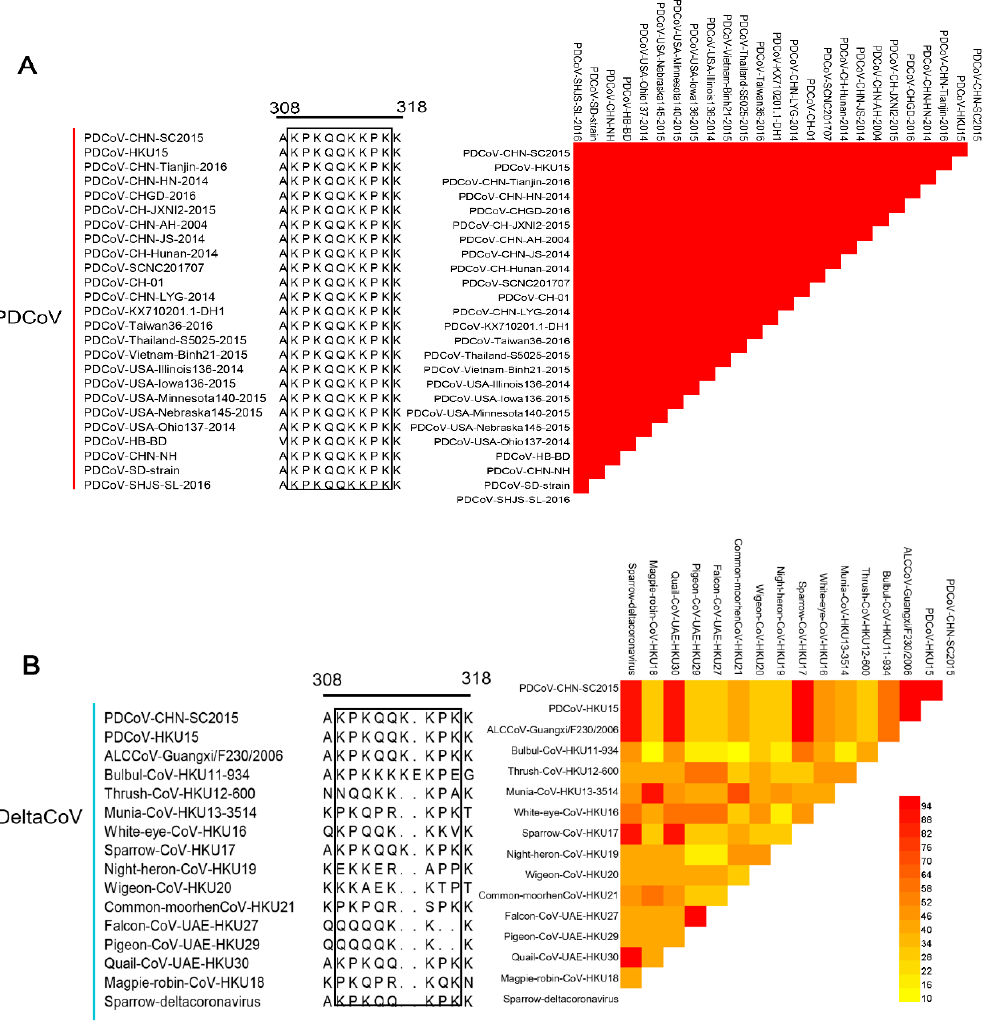
Figure 5. Reactivity of mAb 4E88 with PDCoV, TGEV, and PEDV-infected cells determined by IFA. Binding was visualized with FITC labeled goat anti-mouse antibody, while DAPI was used to visualize the cell nuclei. The strain used for cell infection is shown at the top, and the antibody used for the assay are indicated on the left. Magnification =